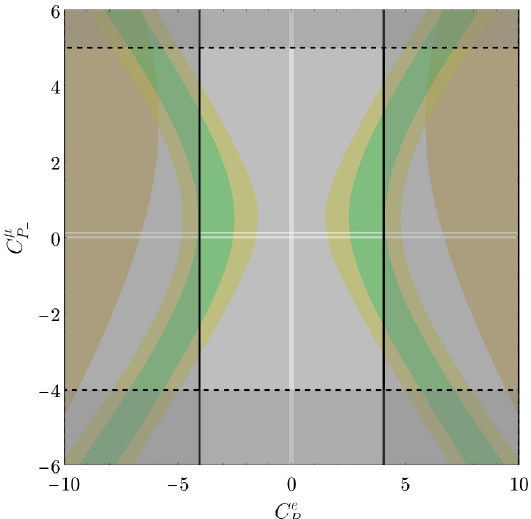
Figure 5. Parameter space for R K ∗ , for an ALP heavier than B mesons. In yellow and green are respectively depicted the 1 σ and 2 σ solutions to the central bin, while in orange are indicated the 1 σ solutions to the low bin. The grey regions around the frame of the figures are excluded at 2 σ by data on semileptonic B → K ∗ e + e − (solid black contours) and B → K ∗ µ + µ − (dashed black contours) decays. The regions excluded by purely leptonic B decays reach the central area and are s also depicted in grey (horizontally for the electron channel and vertically for the muon one) leaving available the narrow white